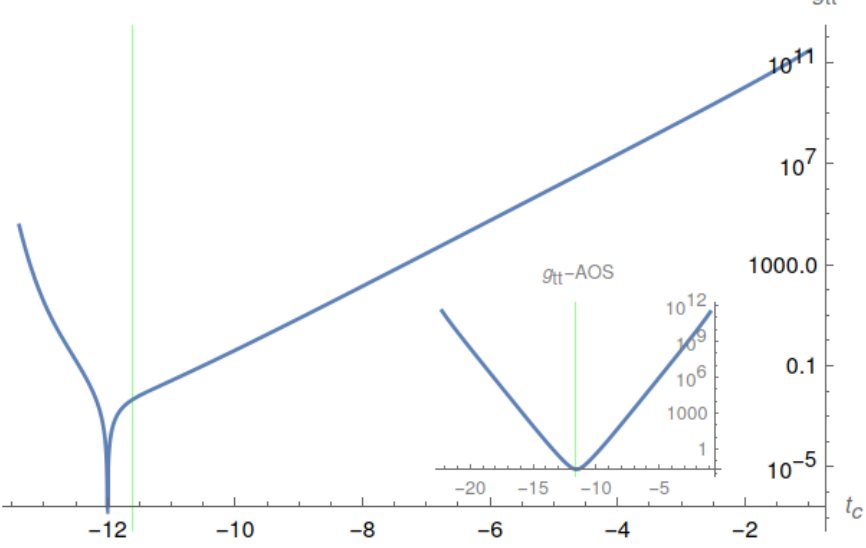
| . The inserting is c t c